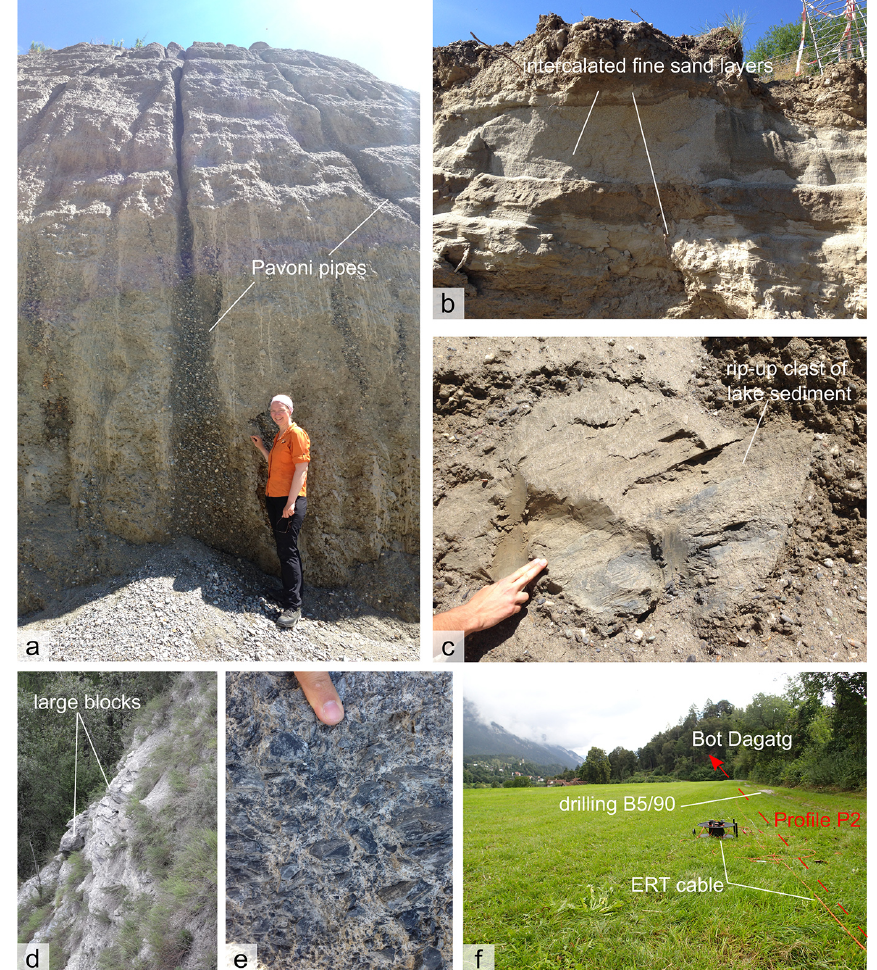
Figure 2. Sedimentological field evidence of the Bonaduz Formation and toma hills used for ERT interpretation. (a) Unstratified, normally graded gravel deposits with fine-grained matrix and vertical Pavoni pipes in a gravel pit near Pardisla. (b) Stratified sands and silts at the top of the Bonaduz type locality at the gravel pit in Reichenau. (c) Large clasts within and on top of the Bonaduz Formation. (d) Outcrop with large rock slabs in toma near Pardisla. (e) Shattered rockslide material with fine-grained matrix at Tuma Casti (see Fig. 1 for location). (f) ERT profile P2 investigating Bot Dagatg rolls over several drilling sites, e.g. “B5/90”. Photo courtesy of M.